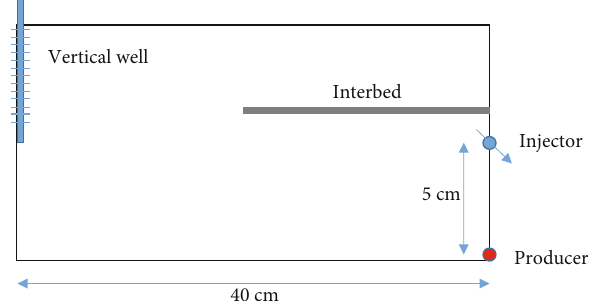
Figure 7: Layout map of vertical and SAGD